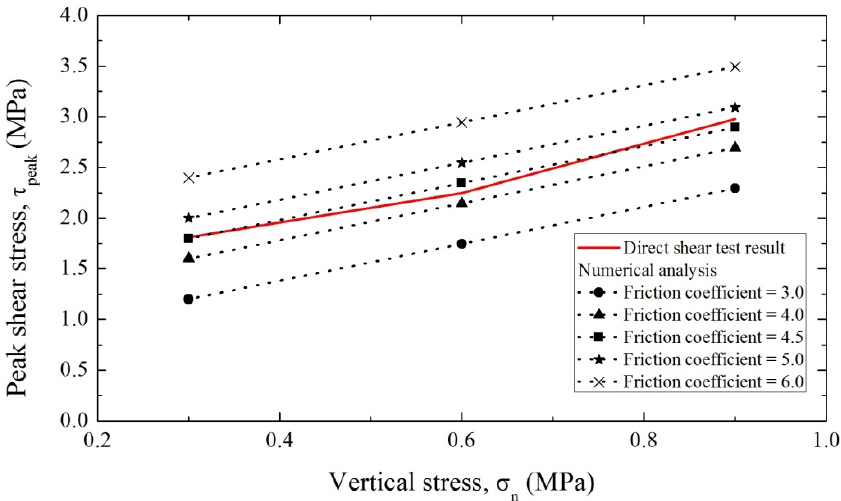
Figure 6. Results of numerical analyses with different friction coefficients for fitting the tangential behavior of the waterproof membrane.